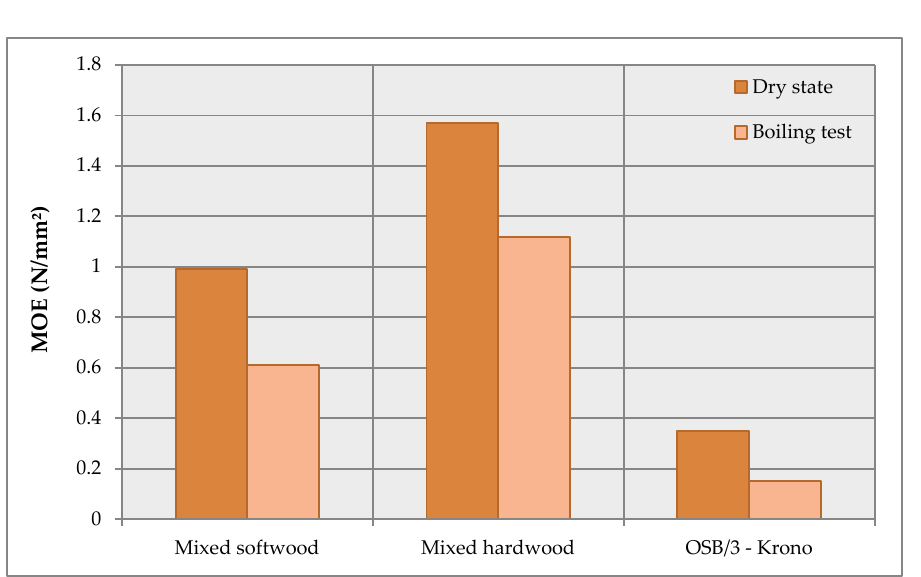
Figure 8. Internal bond of OSB panels from mixed species compared to OSB/3–Krono .